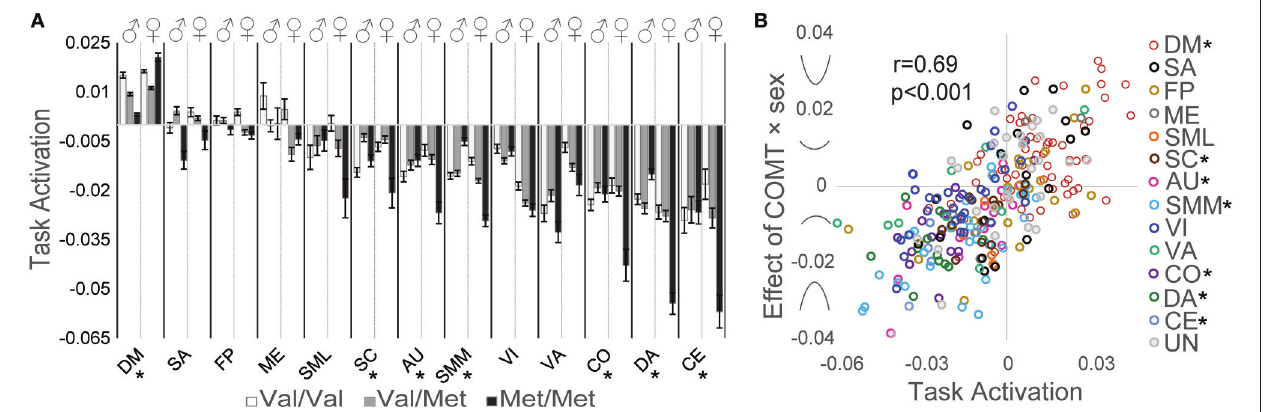
FIGURE 3 | Effects of COMT genotype and sex on network activation during a delay discounting task. (A) Activation of each network is plotted by COMT genotype and sex. For display purposes, beta estimates of task-related activation for all ROIs of a given network are averaged. Error bars reflect standard errors of the mean. (B) Scatter plot of task activation effects plotted against COMT genotype × sex interaction effects on each of the 264 ROIs, color coded by association with large-scale networks. Symbols on the y-axis correspond with the direction of interaction effects, producing u-shaped (positive values) or inverted u-shaped (negative values) relationships. (*) Denotes statistically significant COMT genotype × sex interaction effect measured at the network level. AU, auditory; CE, cerebellar; CO, cingulo-opercular task control; DM, default mode; DA, dorsal attention, FP, fronto-parietal task control; ME, memory retrieval; SA, salience; SML, lateral sensorimotor; SMM, medial sensorimotor; SC, subcortical; VA, ventral attention; VI, visual.